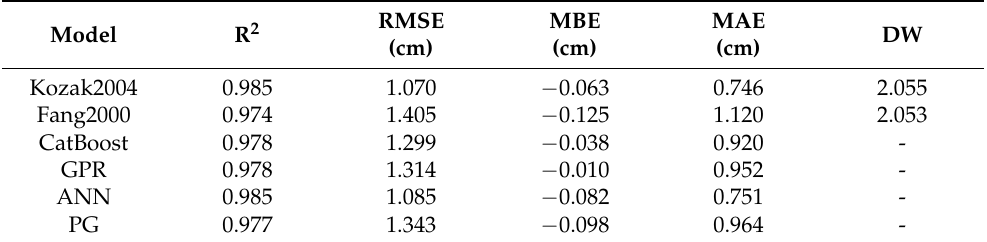
Table 4. Summary statistics for diameter estimate along the stem (d) and DW parameter obtained by autocorrelation correction of the conventional